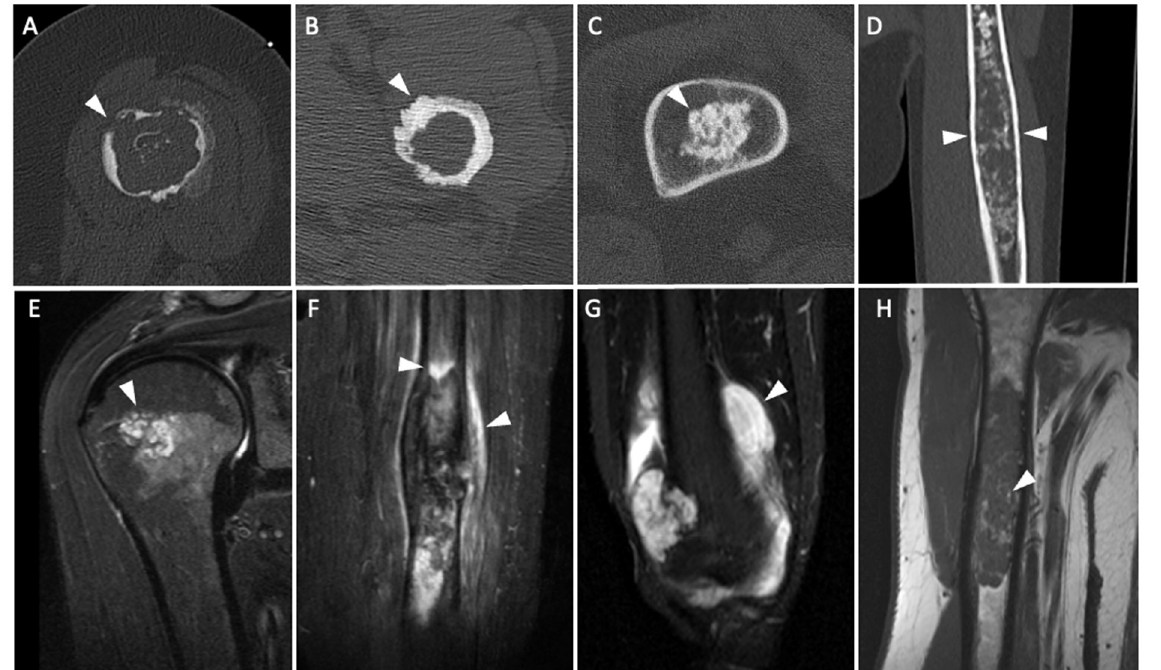
Figure 3. Exemplary computed tomography images demonstrating the features endosteal scallop- ing, cortical penetration ( A ) , periosteal reaction ( B ), Calcifications >2/3 ( C ) and Expansion of the bones ( D ) as well as magnetic resonance (MR) images for discontinuous growth pattern (short-tau inversion recovery (STIR) image) ( E ), edema within the bone and adjacent soft tissue (short-tau inversion recovery (STIR) image) ( F ) , extraosseous soft tissue component (short-tau inversion recovery (STIR) image) ( G ) and fat entrapment (T1 weighted image) ( H ). Features are highlighted by white arrow heads.